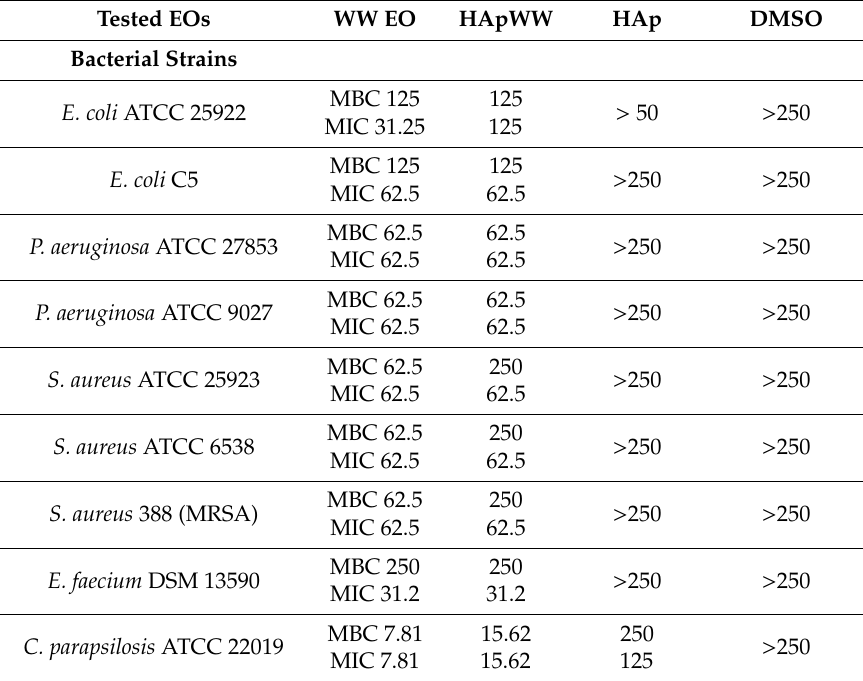
Table 4. MIC and MBC ( µ l / mL) values for WW EO HApWW, HAp and